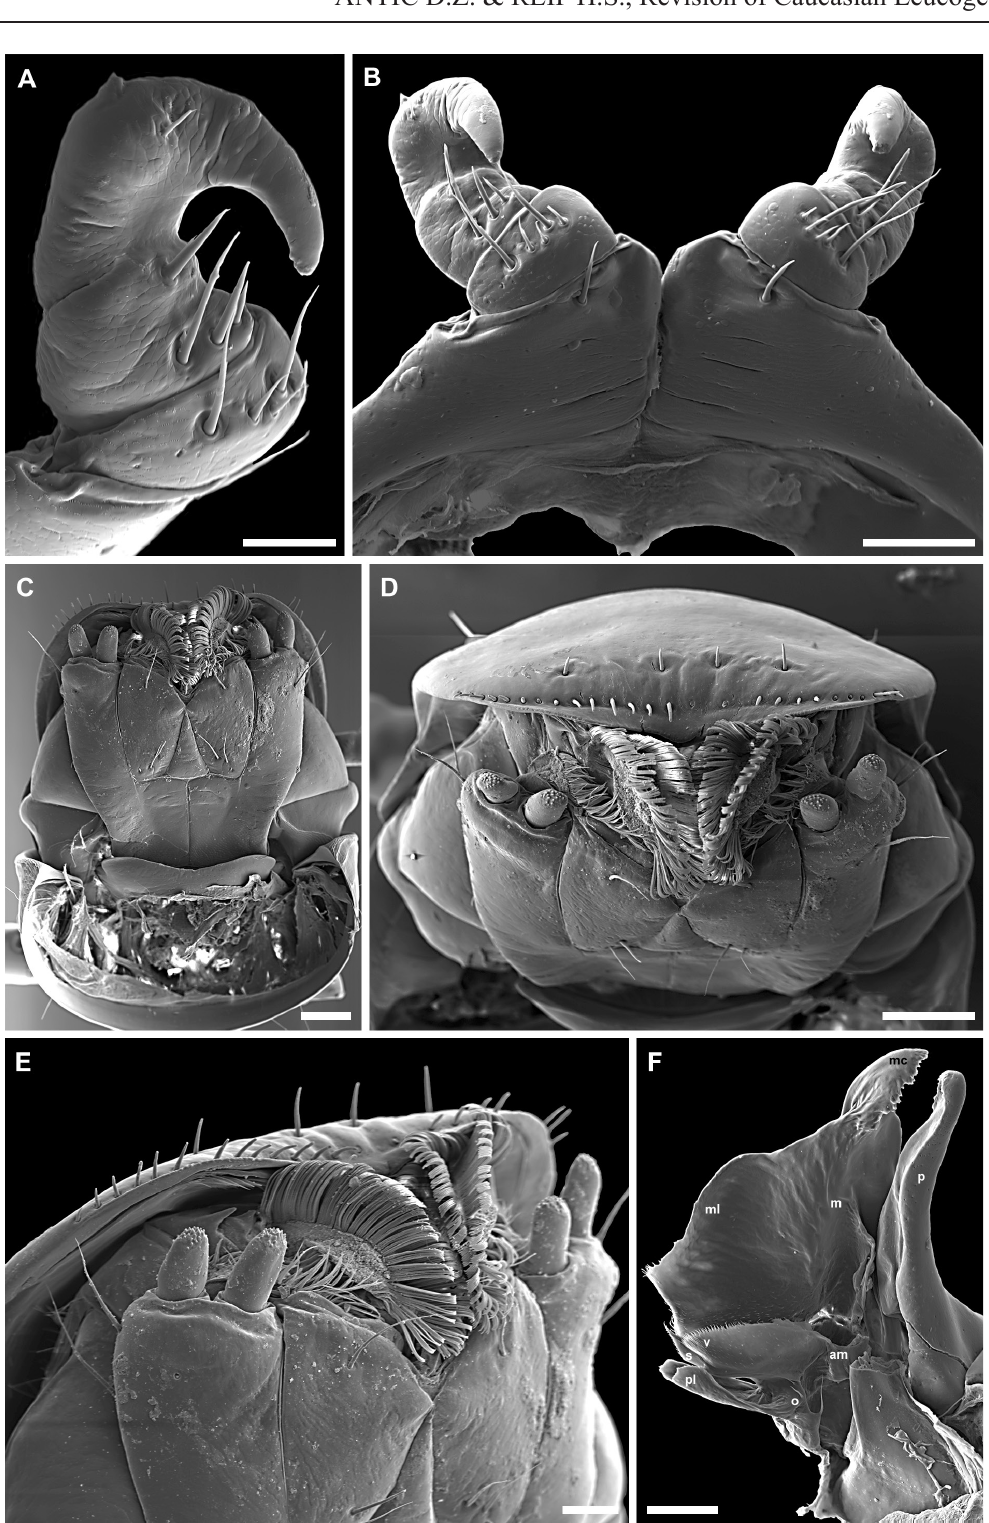
Fig. 37. Leucogeorgia caudata sp. nov., non-type ♂♂ from Adzaba Cave (ZMUM). A . Left leg 1, lateral view. B . Leg-pair 1, anterior view. C . Head, ventral view. D . Head, anterior view. E . Head, ventrolateral view. F . Right gonopods, mesal view. Abbreviations: am = accessory membrane; m = mesomere; mc = mesomeral claw; ml = mesomeral lamella; o = opisthomere; p = promere; pl = protective lamella; s = solenomere; v = velum. Scale bars: A = 0.05 mm; B, E–F = 0.1 mm; C–D = 0.2